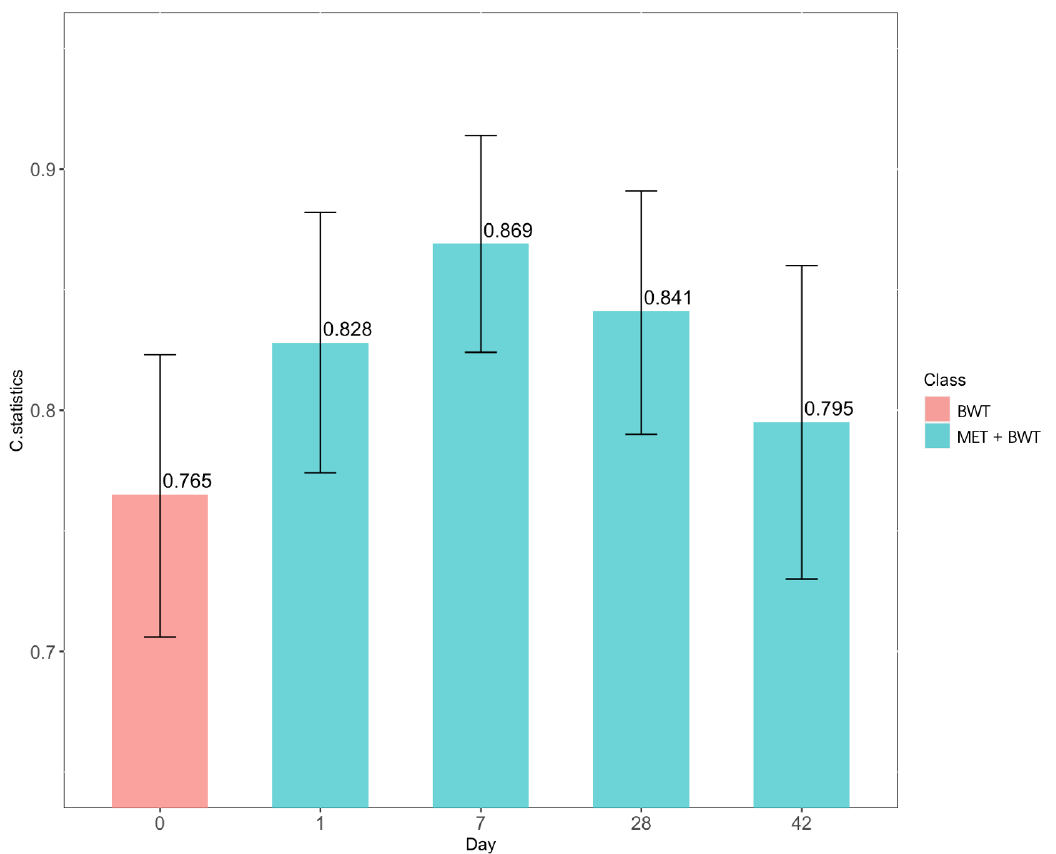
Figure 3. The c-statistics and its 95% CI of the built discriminative models on the 1/3 validation cohort at each time point, utilizing the observed metabolic panel as predictors. MET: the observed metabolic panel. BWT: birth weight.